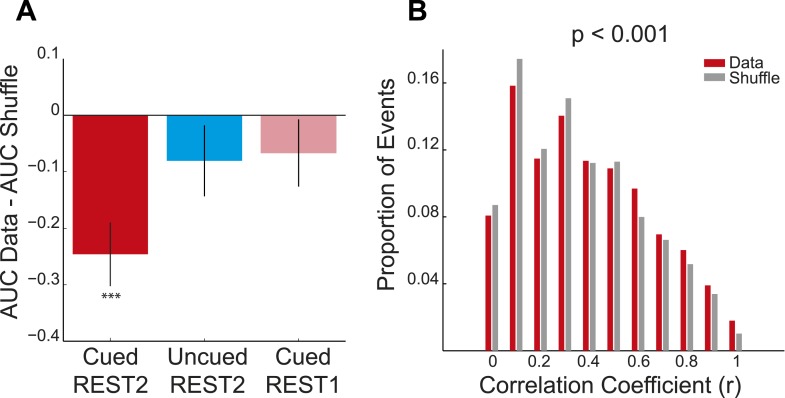
Preplay of cued arm in REST2—distribution-based analysis A mean difference between the bootstrapped cumulative distributions of absolute correlations for the data and the bootstrapped shuffle for the cued and uncued arms in REST2 and the cued arm in REST1.If a place cell template is preplayed then the AUC of the data distribution should be smaller than that of the shuffled distribution (i.e., negative difference score). To assess significance we computed 95% confidence intervals for the difference scores (obtained by subtracting the AUC of the bootstrapped data from the AUC of the bootstrapped shuffle). If the confidence interval did not contain 0 we deemed the data distribution to be significantly different from the shuffle distribution. The distribution for the cued arm in REST2 was found to be significantly different from the shuffle (p < 0.001), yet that of the uncued arm in REST2 and the cued arm in REST1 were not (uncued REST2: p = 0.22, cued REST1: p = 0.14). Black lines on bars show one standard deviation, *** = p < 0.001. (B) Frequency distribution of absolute correlation coefficients between spiking events and future cued arm templates. Red bars represent data and the grey bars the shuffle distribution. p-value above histogram is based on a two-sample Kolmogorov–Smirnov test comparing the data distribution to the shuffle distribution.